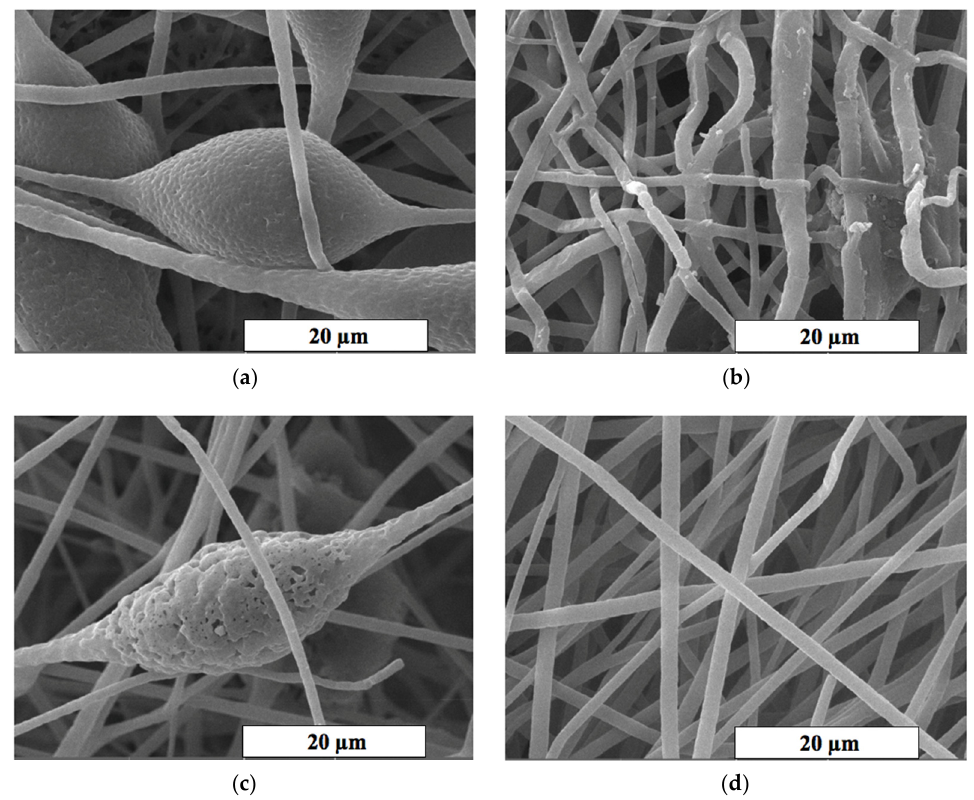
Figure 3. The SEM microphotographs of PHB with different content of the hemin: 0 ( a ), 1 ( b ), 3 ( c ) and 5 ( d ) wt. %.